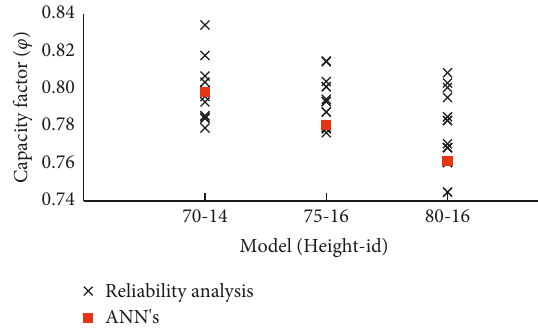
Figure 9: Structural capacity factors corresponding to the verifi- cation models.